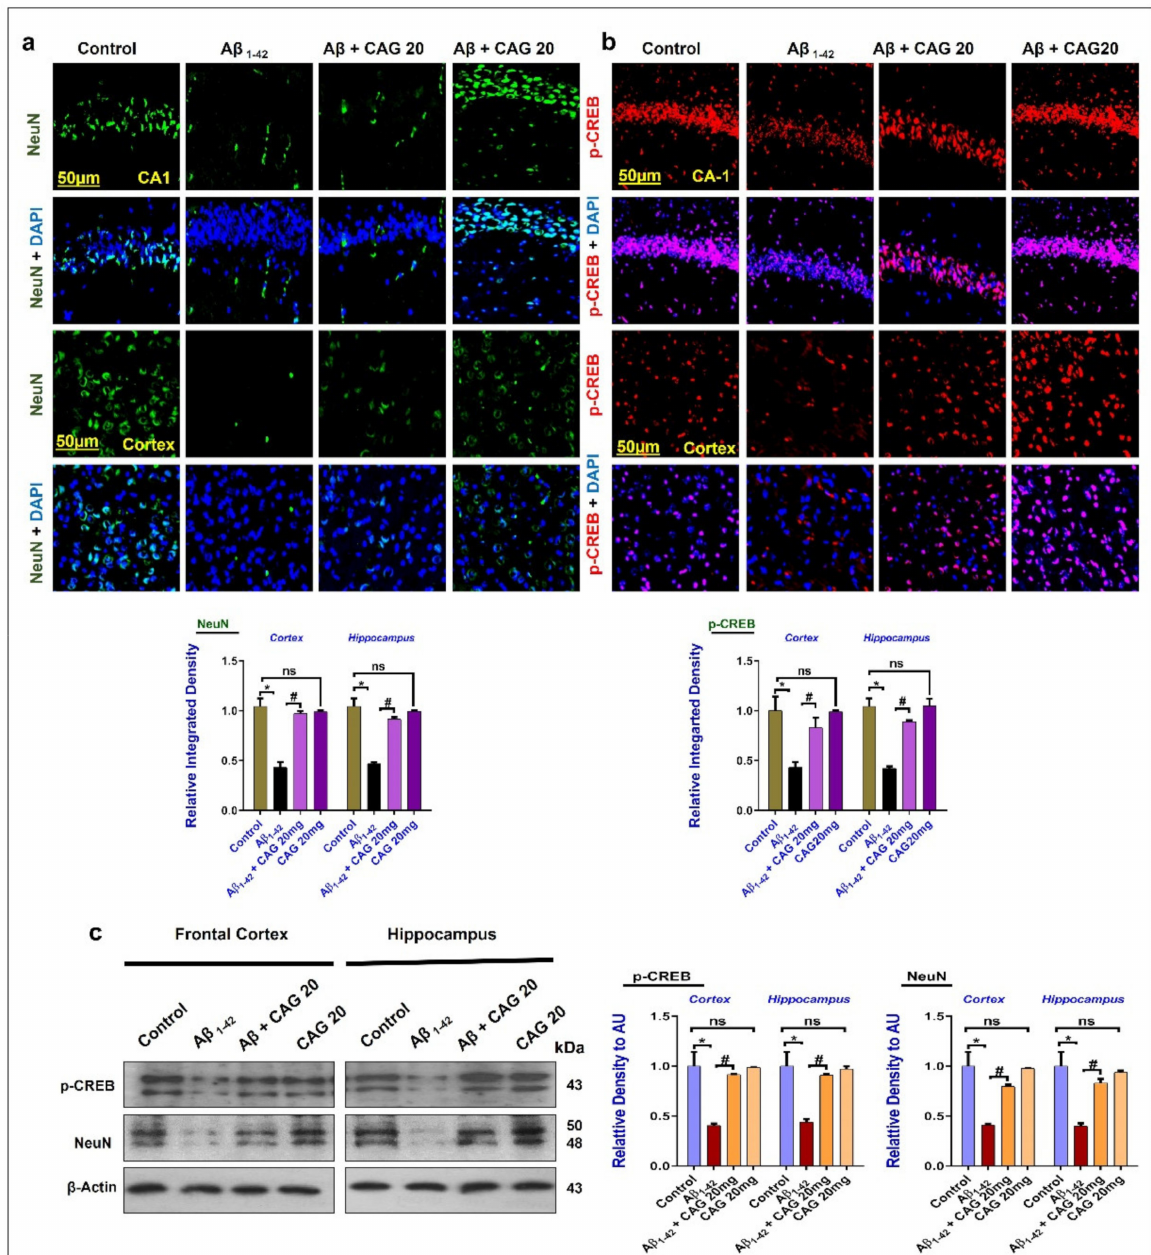
Figure 2. Effects of cycloastragenol against the reduced expressions of p-CREB and NeuN in the experimental mice’s brains. ( a , b ) Immunofluorescence analyses of NeuN and p-CREB in the cortex and hippocampus of the experimental mice. Scale bar 50, the green NeuN and blue is DAPI (for visualizing the nucleus). ( c ) Western blot results of p-CREB and NeuN in the cortex and hippocampus of the experimental mice. The p -value < 0.05 was considered a significant difference. * showing a significantly different from the control group; # significantly different from the A β -injected group. Significant difference = * p < 0.05; # p < 0.05. CAG 20: Cycloastragenol 20 mg/kg, DAPI: 4 (cid:48) ,6-diamidino-2-phenylindole, A β : Amyloid beta, CAG: Cycloastragenol, ns: non-significant